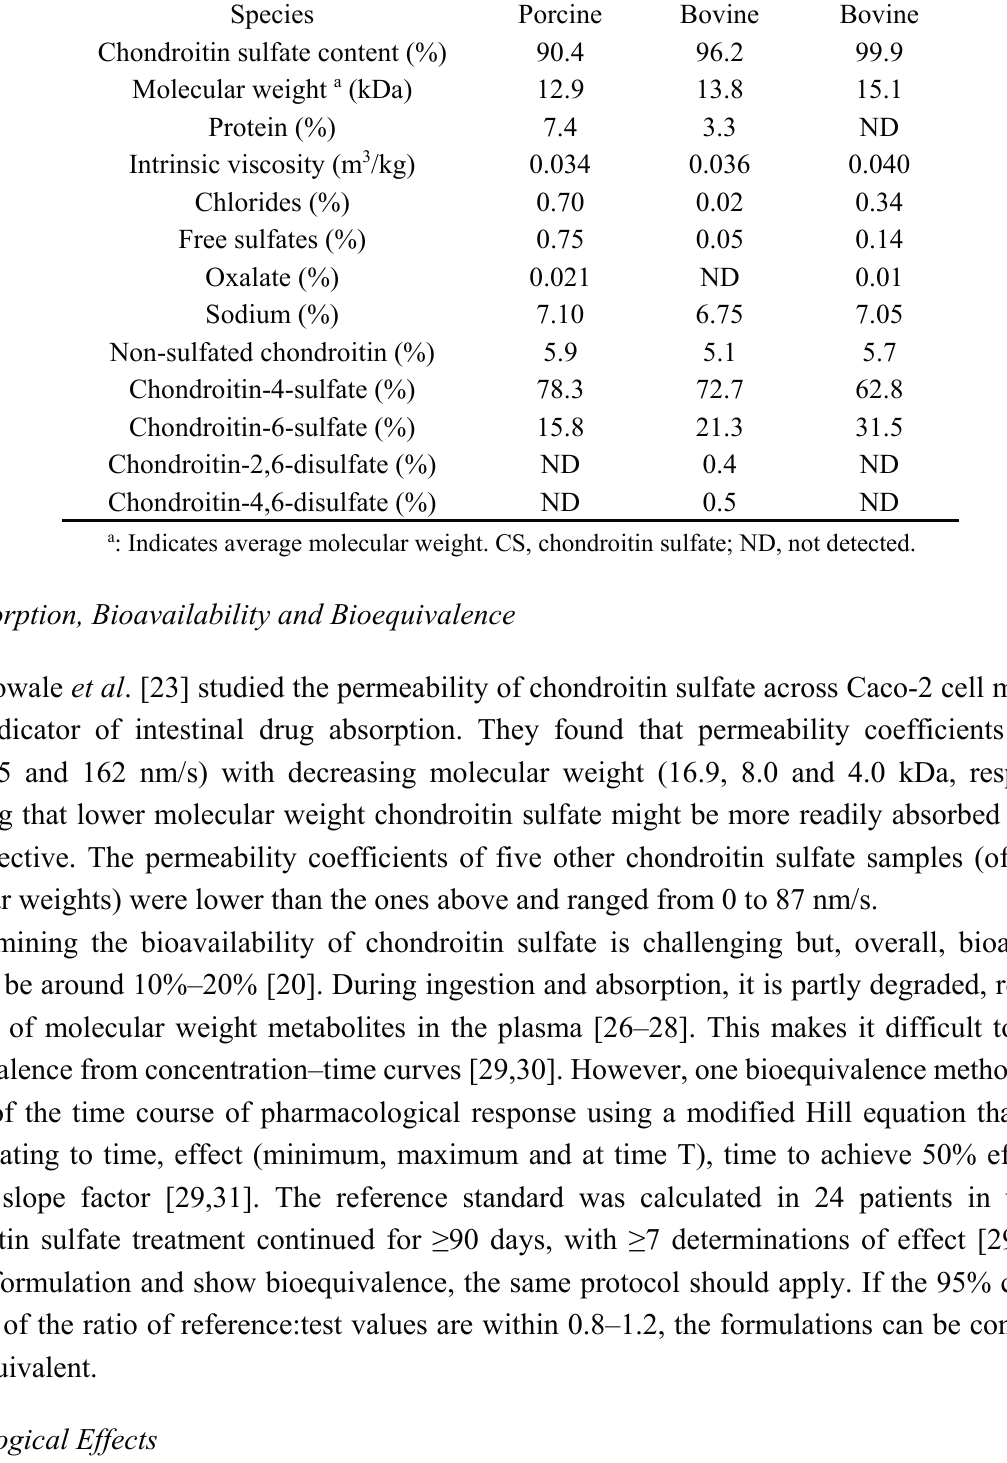
Table 1. Chondroitin sulfate characteristics. Reproduced with permission from Tat, et al . [16]. Characteristic